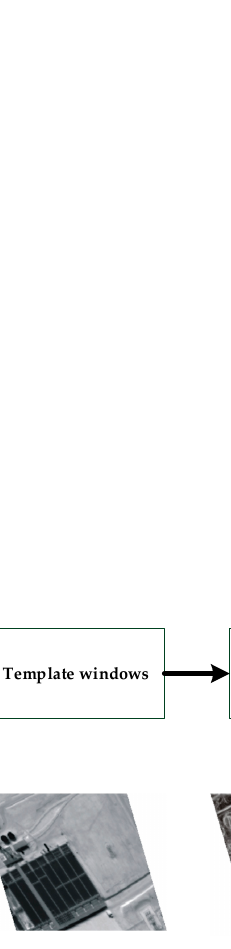
Figure 3. Construction process of histogram of orientated phase congruency (HOPC).